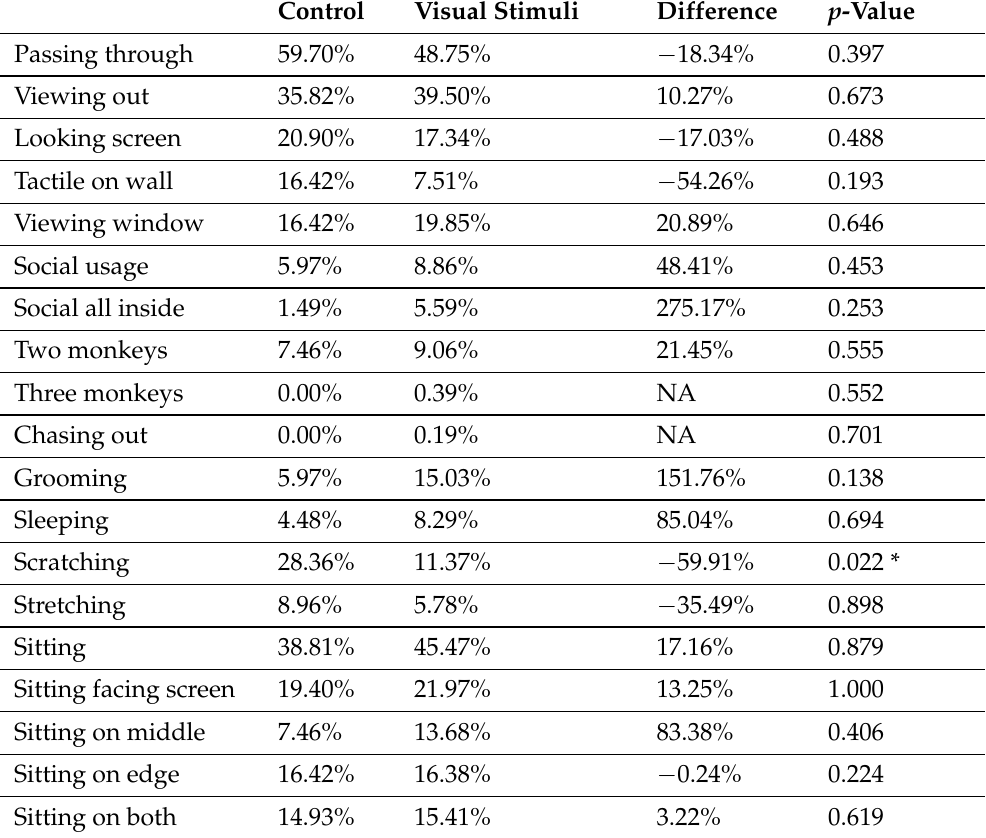
Table 4. Behaviour scores for control and experimental conditions. Percentages are calculated over the total number of interactions for the condition divided by the number of weeks.; the difference is the magnitude of change; *